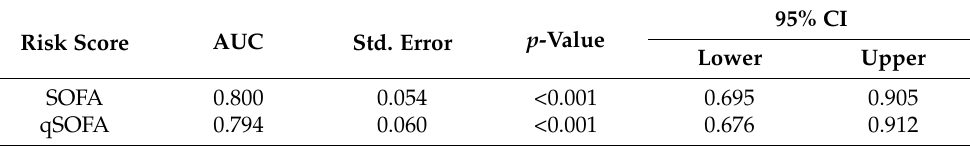
95% CI Lower Upper